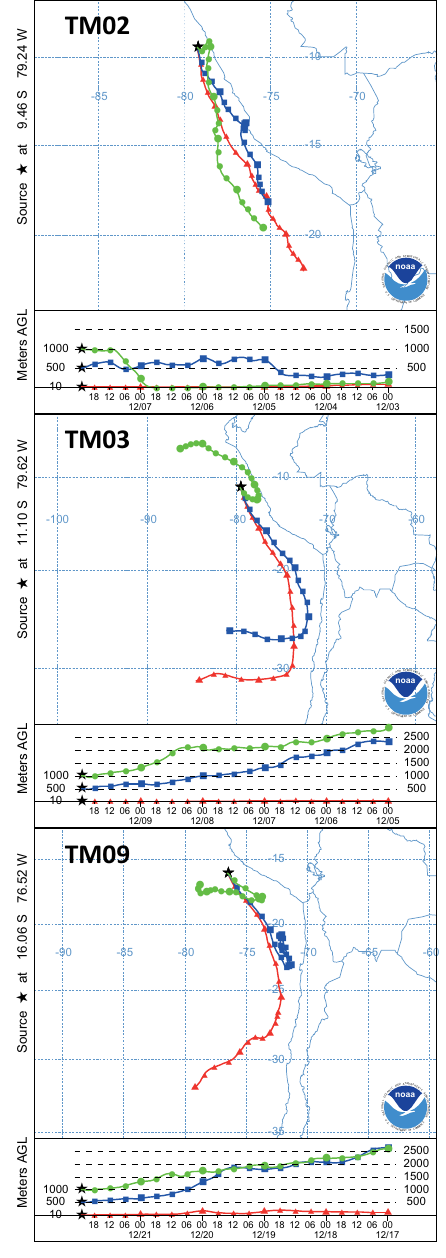
Figure 2. Example 5-day air mass back trajectories for the mid- points of samples TM02, TM03, and